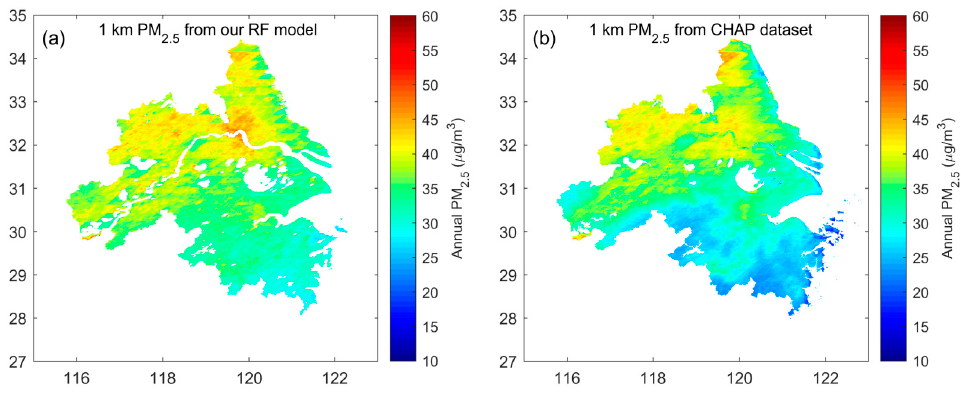
Figure 7. Spatial distribution of annual PM 2.5 in 2020 over the YRD region from our ( a ) 1 km RF model and ( b ) CHAP dataset (https://weijing-rs.github.io/product.html (accessed on 19 June 2021)).